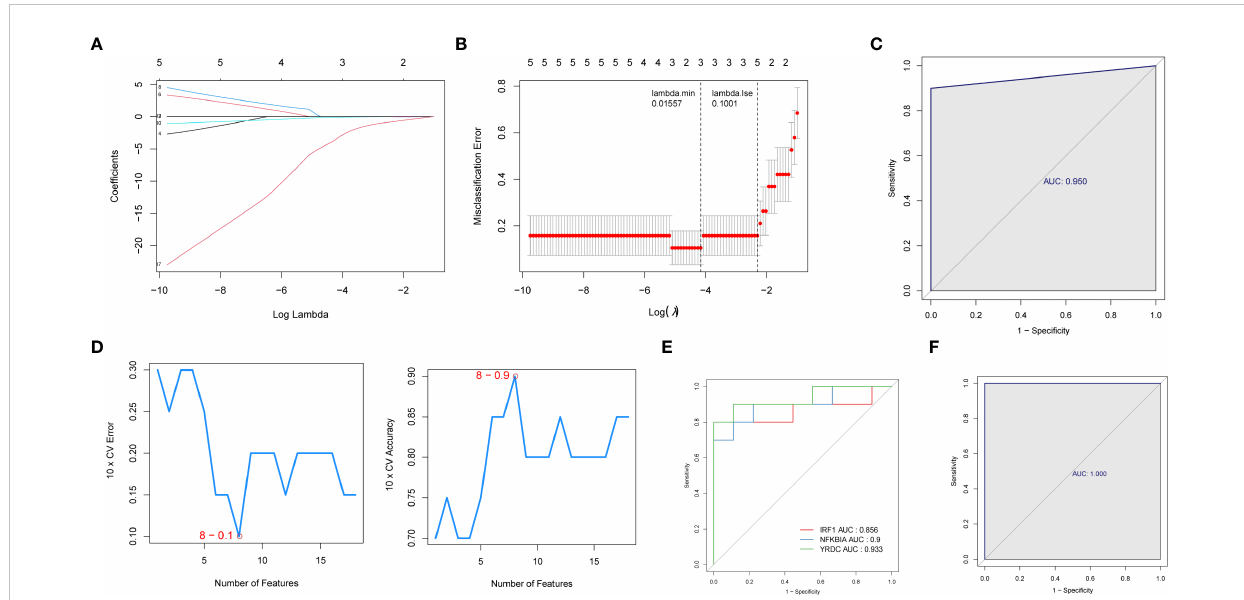
FIGURE 4 Identi fi cation of three signature genes. (A) LASSO Cox regression analysis to shrink estimated coef fi cients to zero. (B) Cross-validation was used to choose an optimal l value in the LASSO selection diagram. The two dotted lines indicated two particular values of l . The left side was l min, and the right side was l 1se. The l min was selected to build the model for accuracy in our study. (C) ROC analysis was adopted to assess the ef fi cacy of the LASSO regression analysis results model (AUC = 0.950). (D) Plots of eight feature genes selection by SVM-REF. (E) ROC curve of three signature genes. (F) The ROC curve for L is the logistic regression model of three signature genes (AUC =